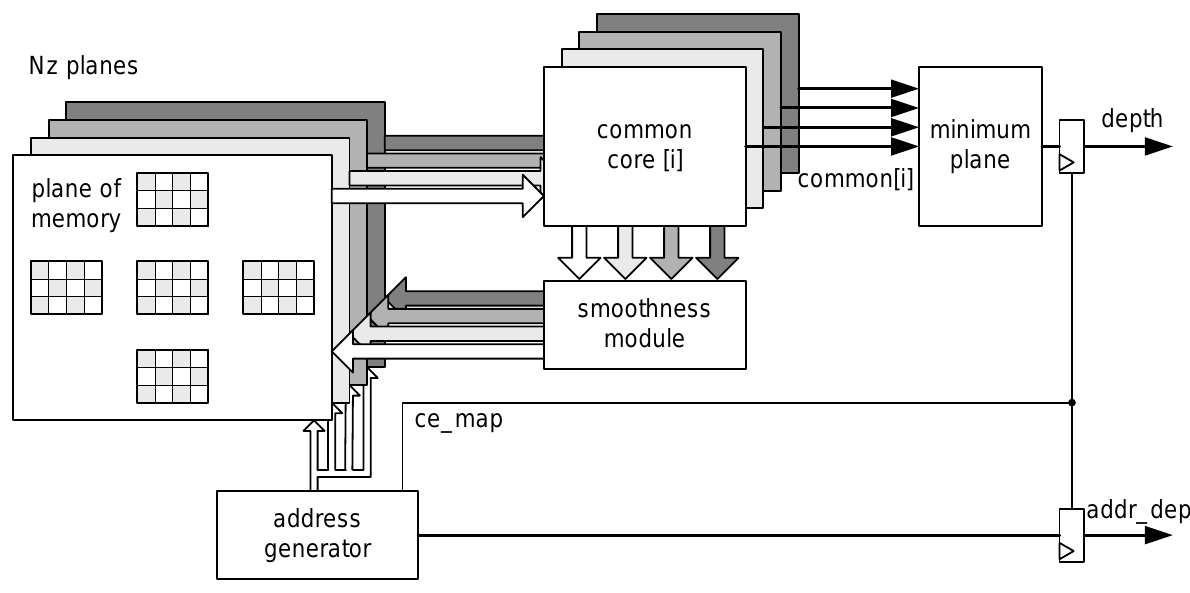
Figure 2. Architecture of the designed belief propagation